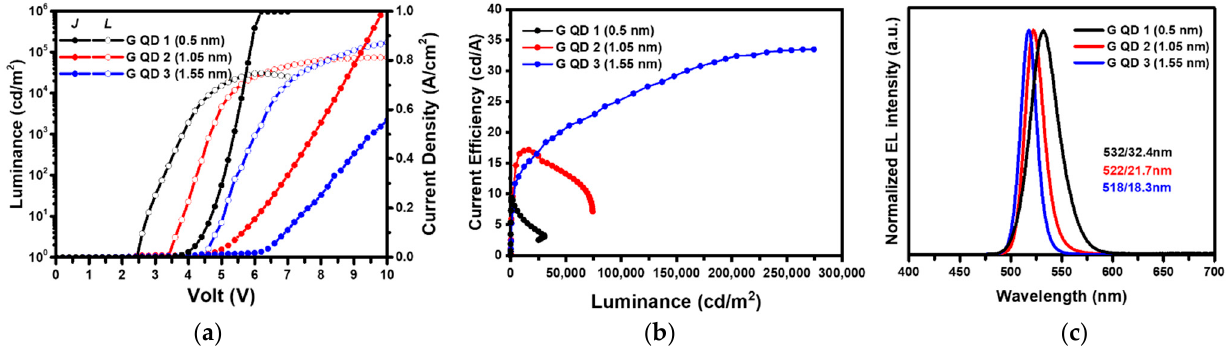
Figure 1. ( a ) J – V – L and ( b ) CE – L characteristics and ( c ) EL spectra of the BEQLEDs prepared from G- QDs with different shell thickness. All the devices were prepared using the same device process and the BEQLED structure, i.e., ITO/PEDOT:PSS (40 nm)/PVK (17 nm)/QDs (25 nm)/ZnO (20 nm)/Al (100 nm). In ( b ), the device with G-QD-3 should possess a maximum luminance more 280,000 cd · m − 2 , which is the detection limit of the luminance